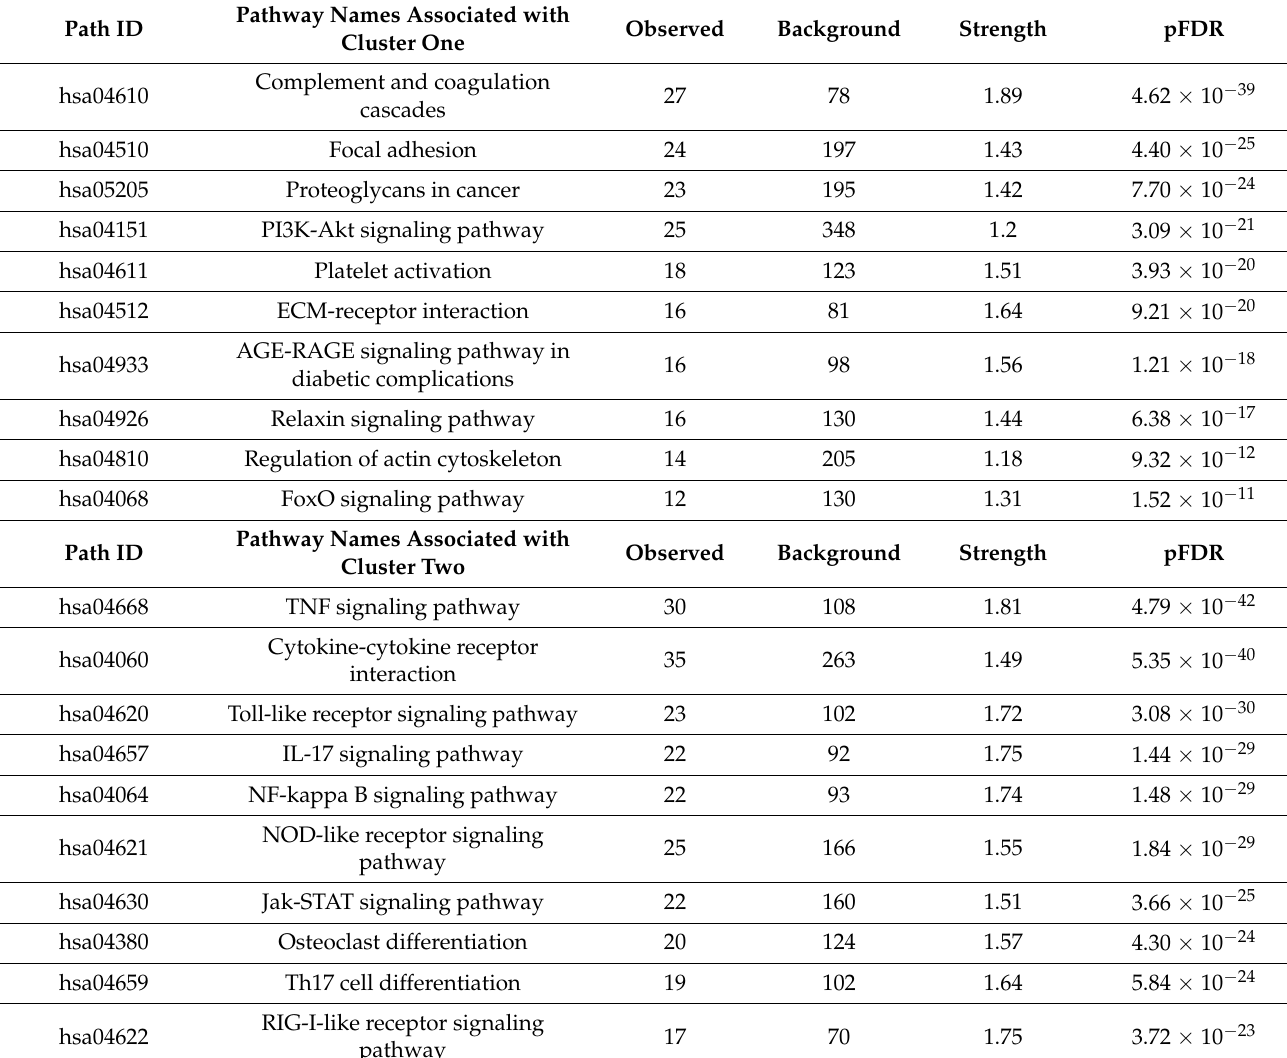
Table 4. KEGG pathway classifications of the differently expressed proteins and genes in cluster one and two of death due to